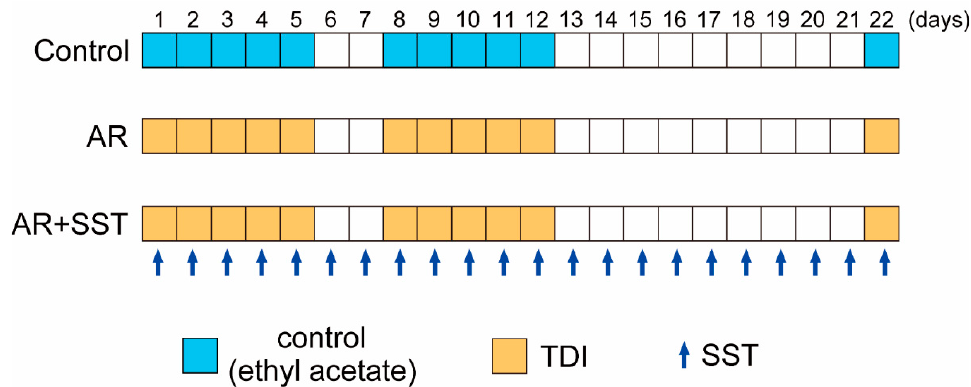
Figure 1. The experimental schedule to develop an allergic rhinitis (AR) rat model and clarify the effect of SST on AR development. The AR and AR + SST groups were sensitized by dropping 5 μ L of 10% TDI dissolved in ethyl acetate and olive oil into each nostril for 5 consecutive days. The rats of the Control group were treated with intranasal ethyl acetate and olive oil instead of TDI in the same protocol. After 2 days of rest, the rats were resensitized in the same way for 5 days. Ten days after the second course of sensitization, the rats were provoked by intranasal administration of 5 μ L of 10% TDI. SST was administered to the AR + SST group rats from the first day of the initial sensitization until the day of the final challenge with TDI (a total of 22 days).